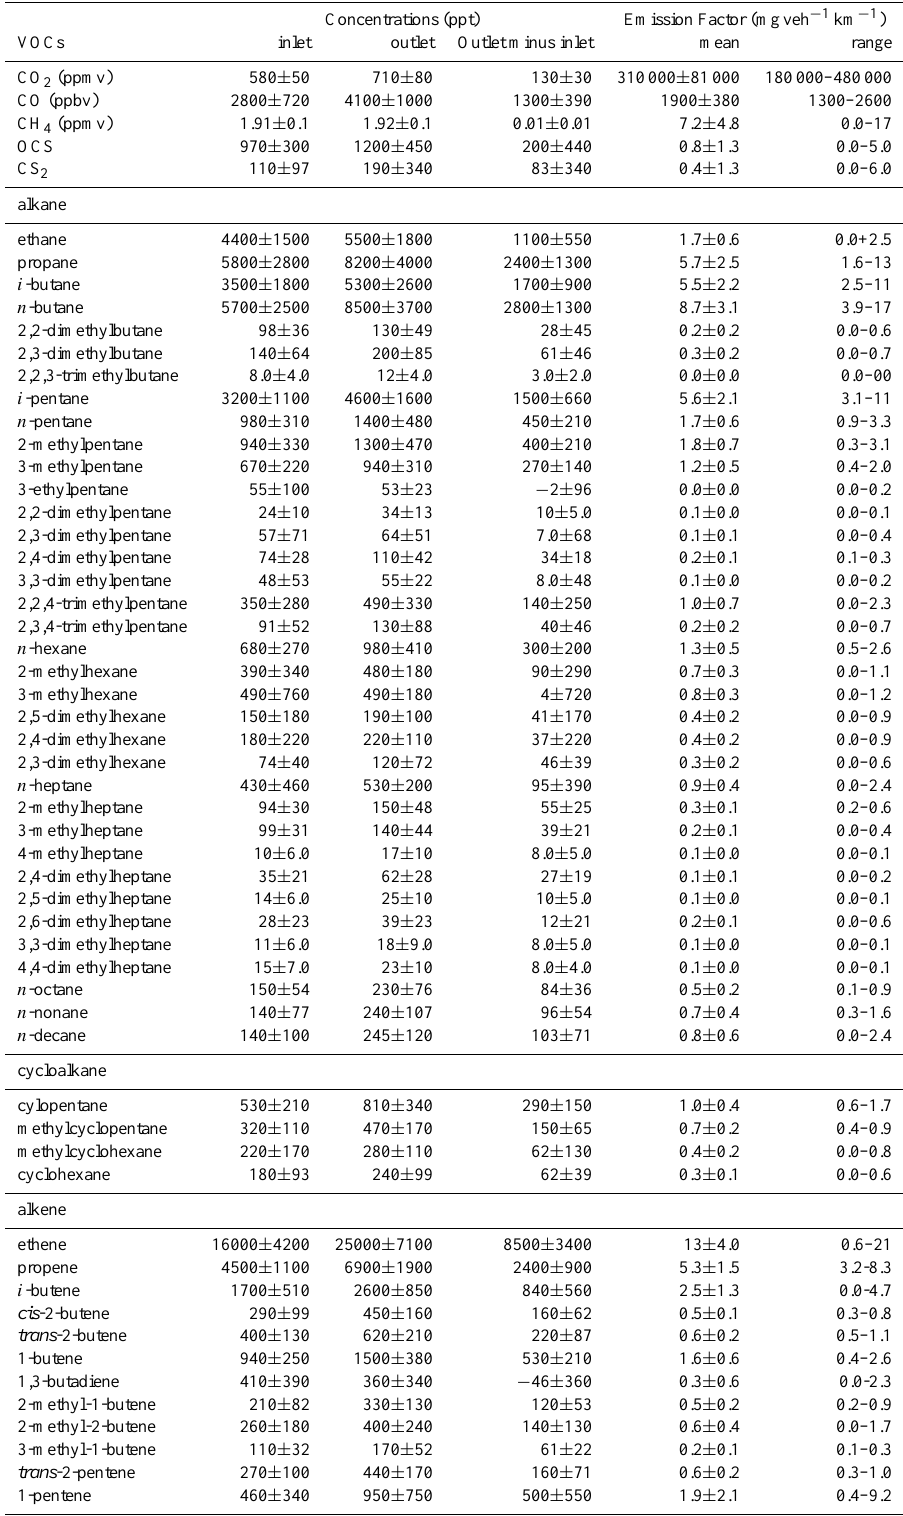
Table 2. Average concentrations of VOCs and their emission factors in summer and